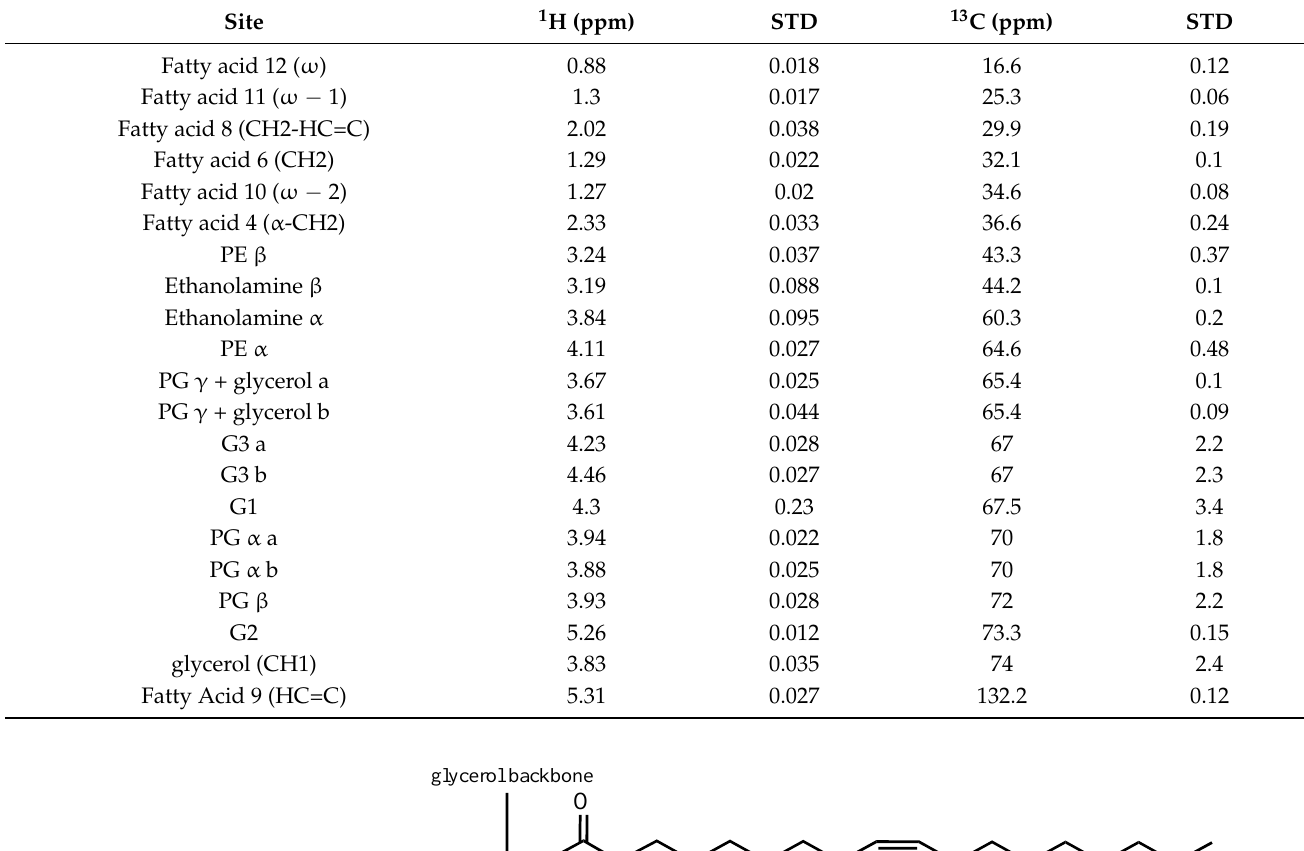
Table 2. Chemical shift assignments for liposome lipids and lipid hydrolysis products measured in